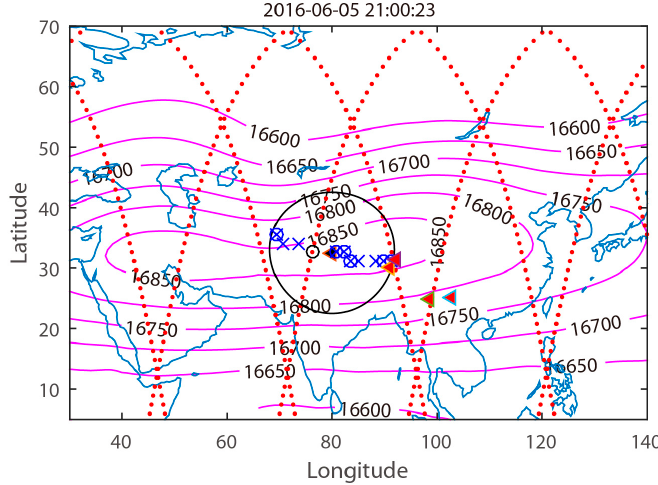
Figure 1. Trajectory distribution of MLS ozone profiles at 50 hPa on 5 June 2016 (red solid dots); the position of the nearest matching MLS profile (black hollow circle) to the Shiquan River ozonesonde station (black triangle); the remaining 16 matching MLS ozone profiles (blue crosses or hollow circles); the maximum matching distance (large black circle); and locations of the other ozonesonde stations (red triangles for Lhasa, Nagqu, Tengchong, and Kunming). The geopotential height (pink contours; m) in July and August 2016 is from the ERA-Interim dataset.